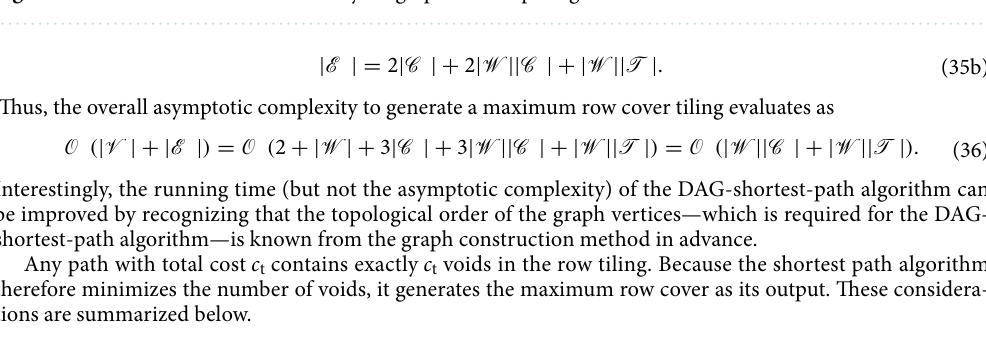
Figure 8. Transducer-based directed acyclic graph for computing the maximum row